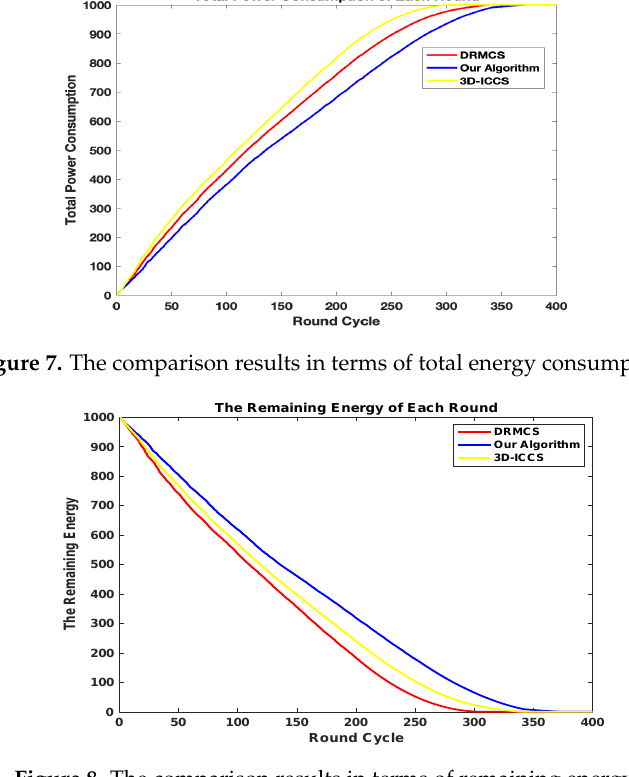
Figure 8. The comparison results in terms of remaining